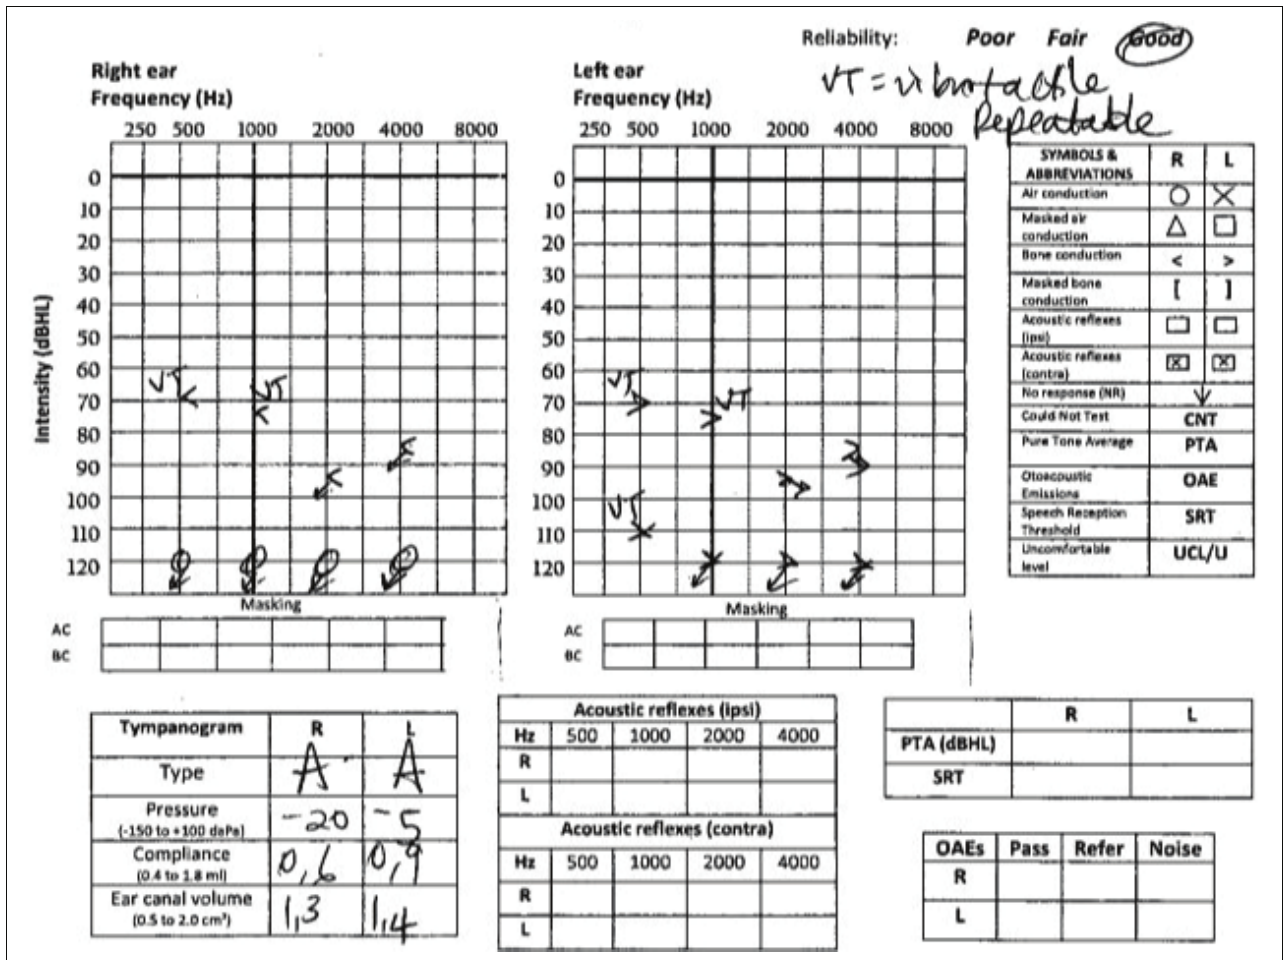
FIGURE 1: Audiogram at the time of admission demonstrated bilateral profound sensorineural hearing